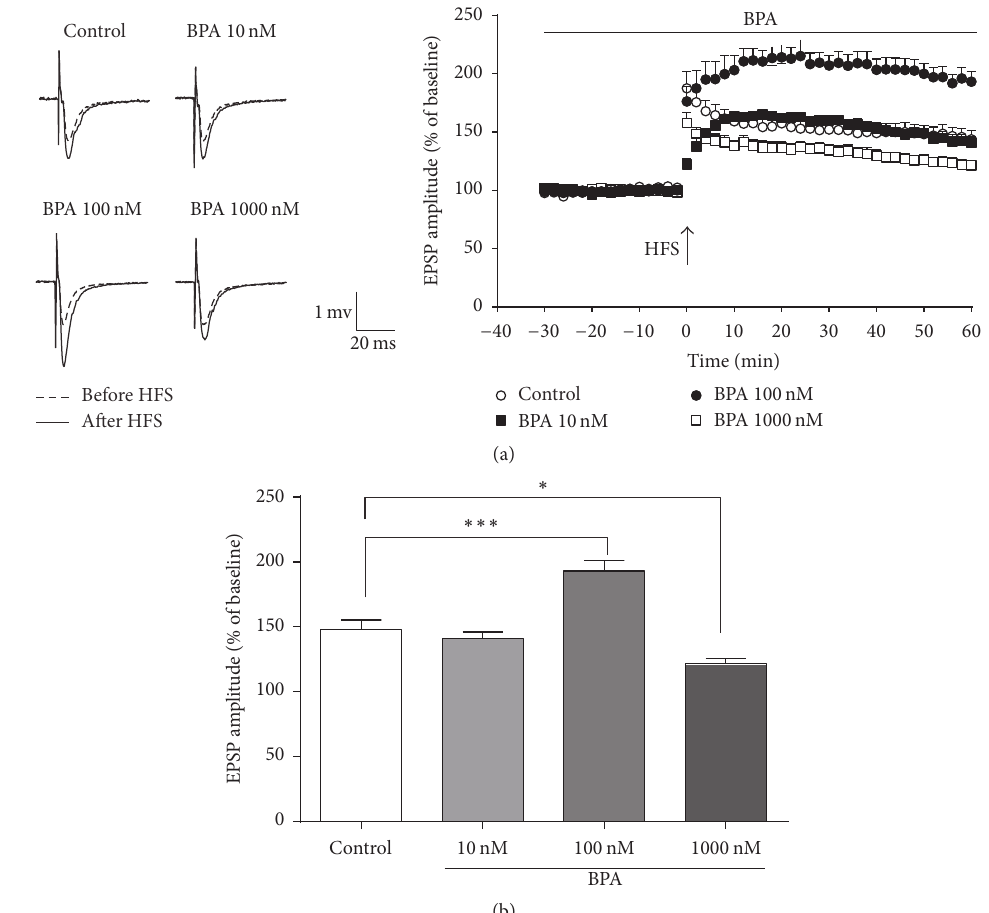
Figure 1: The biphasic effect of BPA on LTP in rat dentate gyrus in vitro. (a) High-frequency stimulation induced LTP in the medial perforant path of the dentate gyrus of acute rat hippocampus slices (open circles, 𝑛 = 8 ). Applications of BPA are indicated at concentrations of 10nM (filled squares, 𝑛 = 8 ), 100nM (filled circles, 𝑛 = 8 ), and 1000nM (open squares, 𝑛 = 8 ), respectively. All hippocampal slices were preperfused with ACSF, 30 min before HFS, to obtain baseline EPSP amplitude. (b) Summary of the major experimental outcomes. The average fEPSP amplitudes at 60min after HFS in separate perfusion of different concentration BPA. Applications of BPA 100 nM and BPA 1000 nM have significant effects on LTP, ∗ 𝑝 < 0.05 , ∗∗∗ 𝑝 < 0.001 as compared to controls. Solid and dashed example traces before HFS and after HFS,